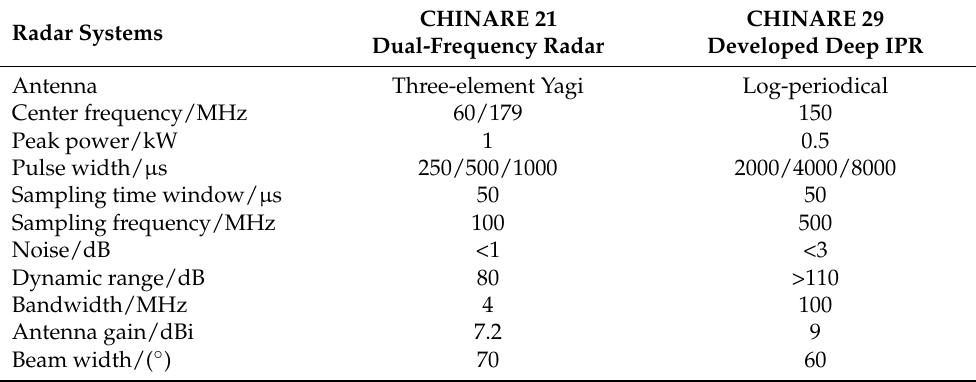
Figure 1. Bedrock topography in the vicinity of Dome A and Kunlun Station (contour spacing 100 m), white lines show ground-based radar surveys, asterisks show the Kunlun Station and the Dome A, 1–4 show the radar paths during the CHINARE 21, 5–8 show the radar paths during the CHINARE 29. Table 1. Technical characteristics of IPR systems used during CHINARE 21 and CHINARE 29 [39].